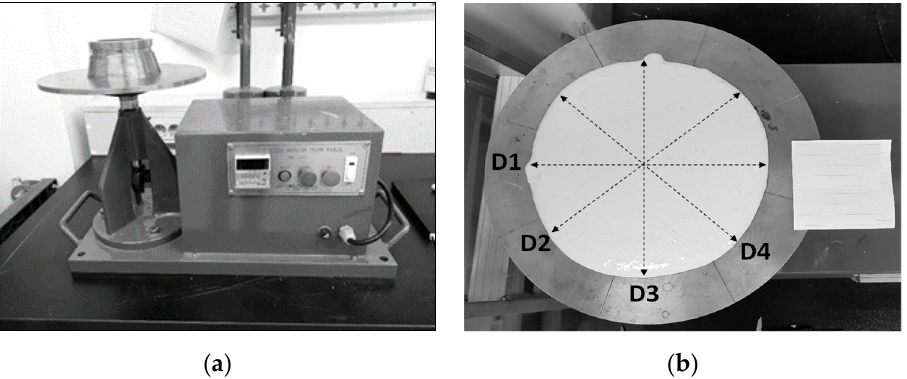
Figure 1. ( a ) Motorized flow table for flowability testing. The conical mold has a 100-mm base diameter, 70-mm top diameter and 50-mm height. ( b ) The average of the four spread diameter values from D1 to D4 is presented as the flow diameter in Table 1.